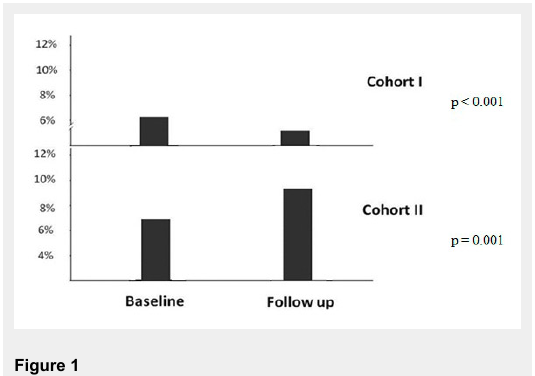
Figure 1 Proportion of patients with LDL cholesterol <70 mg/dl in both cohorts.